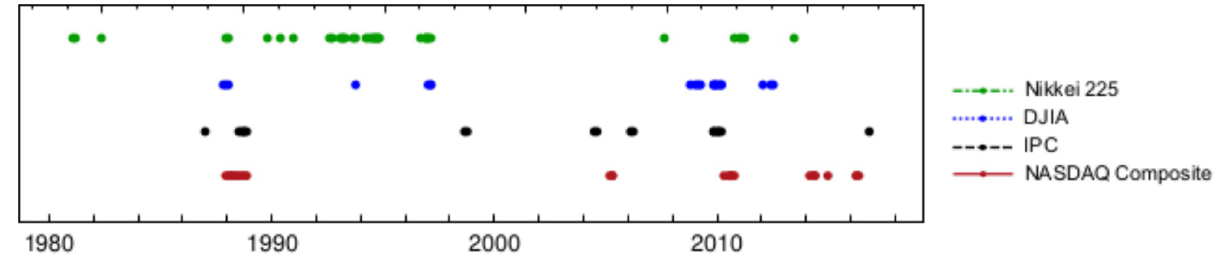
Fig 10. Colored points, show dates from the parametric test where events observed in Fig 9 have a p -value below the α = 0.05 and then geometric model for any p can not be applied to describe runs size distribution for the different analyzed markets at that significance level. Again, for easy reading colored points are enlarged.